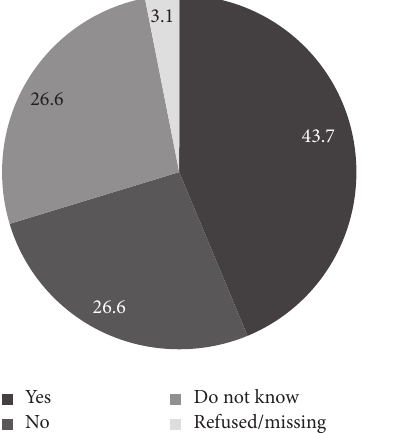
Figure 3: Aware that cervical cancer can be prevented by an HPV vaccine, among those who have heard of HPV, Odisha, India ( 𝑛 = 64